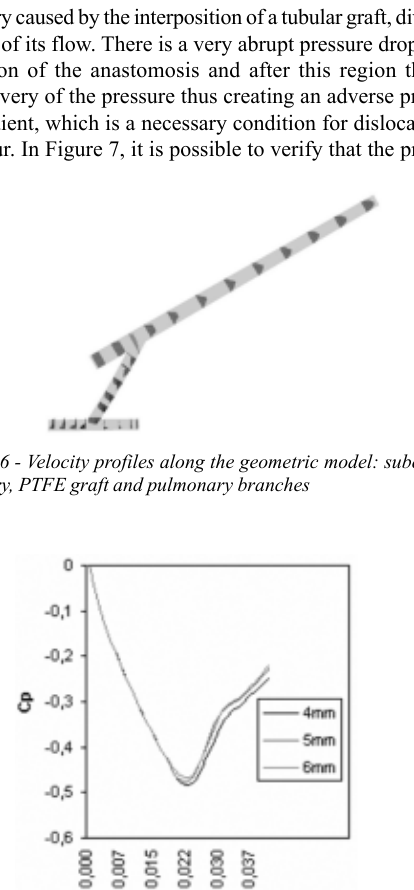
Fig. 5 - Axial velocity profile (m/s) at the right (A) and left (B) pulmonary artery outflow tracts. The position of r/R has reference to the central axis, where the value of 1 presents the central axis of the vessels and the value 0 the internal walls of the analysis. Some simulations were performed with the conditions of defined circuits by Migliavacca et al. [19], with a imposition of established flow in the outflow tract of the subclavian artery